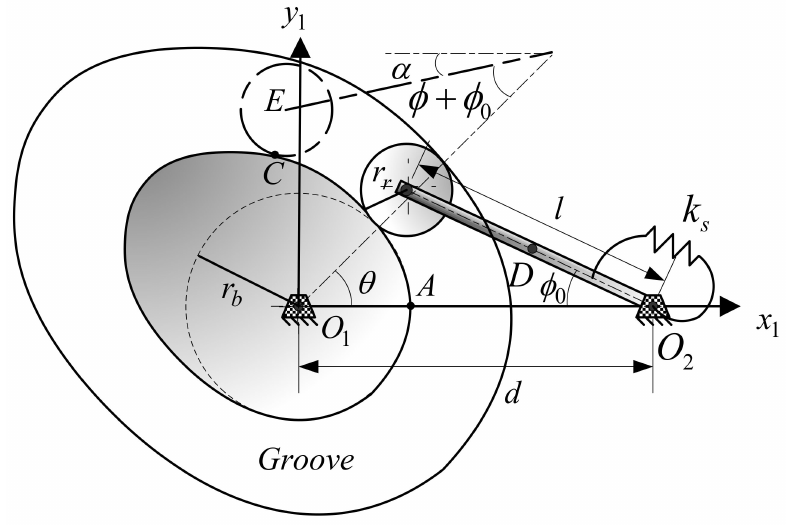
Figure 1. Schematic diagram of the oscillating roller-follower cam system.